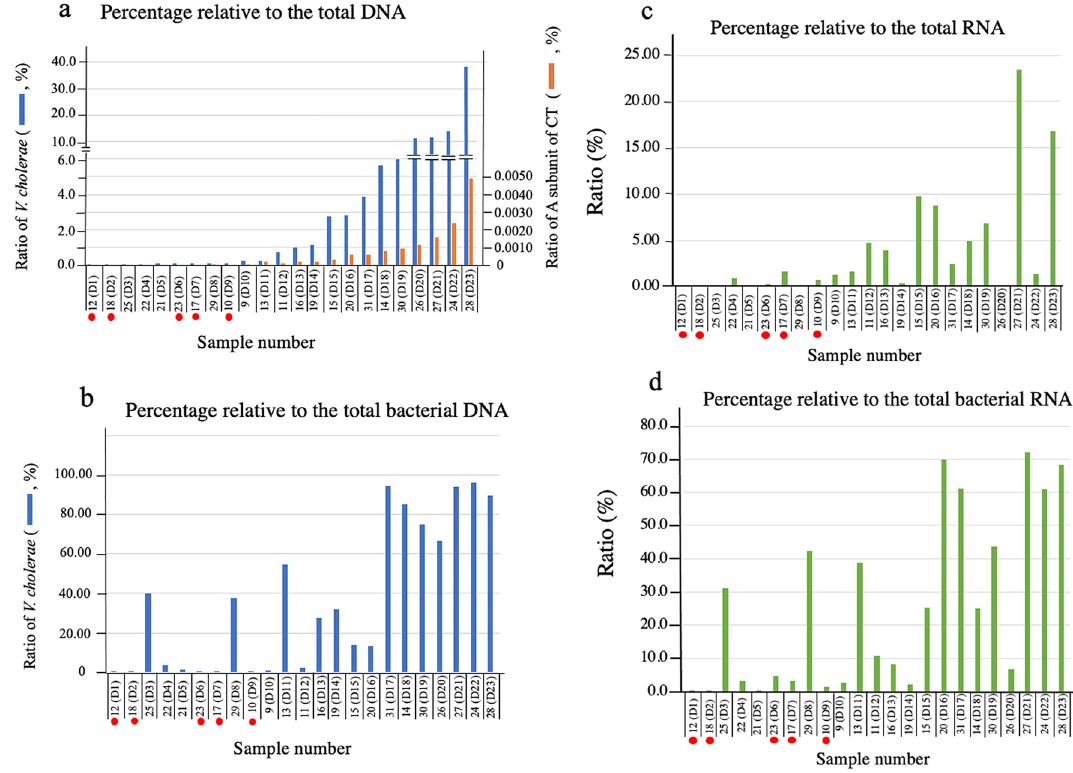
Figure 3. The ratios of DNA and RNA derived from V. cholerae in stool samples. The DNA and RNA in the stool samples from 23 patients who were diagnosed with cholera disease were extracted using a commercially available kit. Subsequently, the RNA samples were treated with DNase I to remove DNA from the samples. Reverse-transcribed DNA was prepared from these RNA samples using random primers and reverse transcriptase. The extracted DNA and reverse-transcribed DNA were investigated by a metagenomic sequencing analysis to clarify the origin of individual DNA and RNA. The origin of the DNA sequences was assigned by mapping to a database that included human and microorganism sequences. The obtained numbers of total reads, total bacterial reads, reads originating from V. cholerae , reads originating from ctxA in each sample are shown in Supplementary Tables S3 (the data from DNA) and S4 (the data from RNA). The percentages of reads of DNA from V. cholerae and from ctxA relative to the total reads are presented by blue bar and red bar in panel a, respectively. The percentages of reads of DNA from V. cholerae relative to the total bacterial reads are presented in panels b. Samples are arranged in ascending order of the ratio of reads from V. cholerae to the total reads in the DNA analysis. The ranking of each sample is presented by the numbers in parentheses starting with the letter D. The samples in these panels are arranged in the order of the D number. Similarly, the ratio of reads from V. cholerae to the total RNA reads and the total bacterial RNA are presented in panels c and d, respectively. The samples indicated by red circle are samples from the diarrheal stools of a patients who are focused on in this